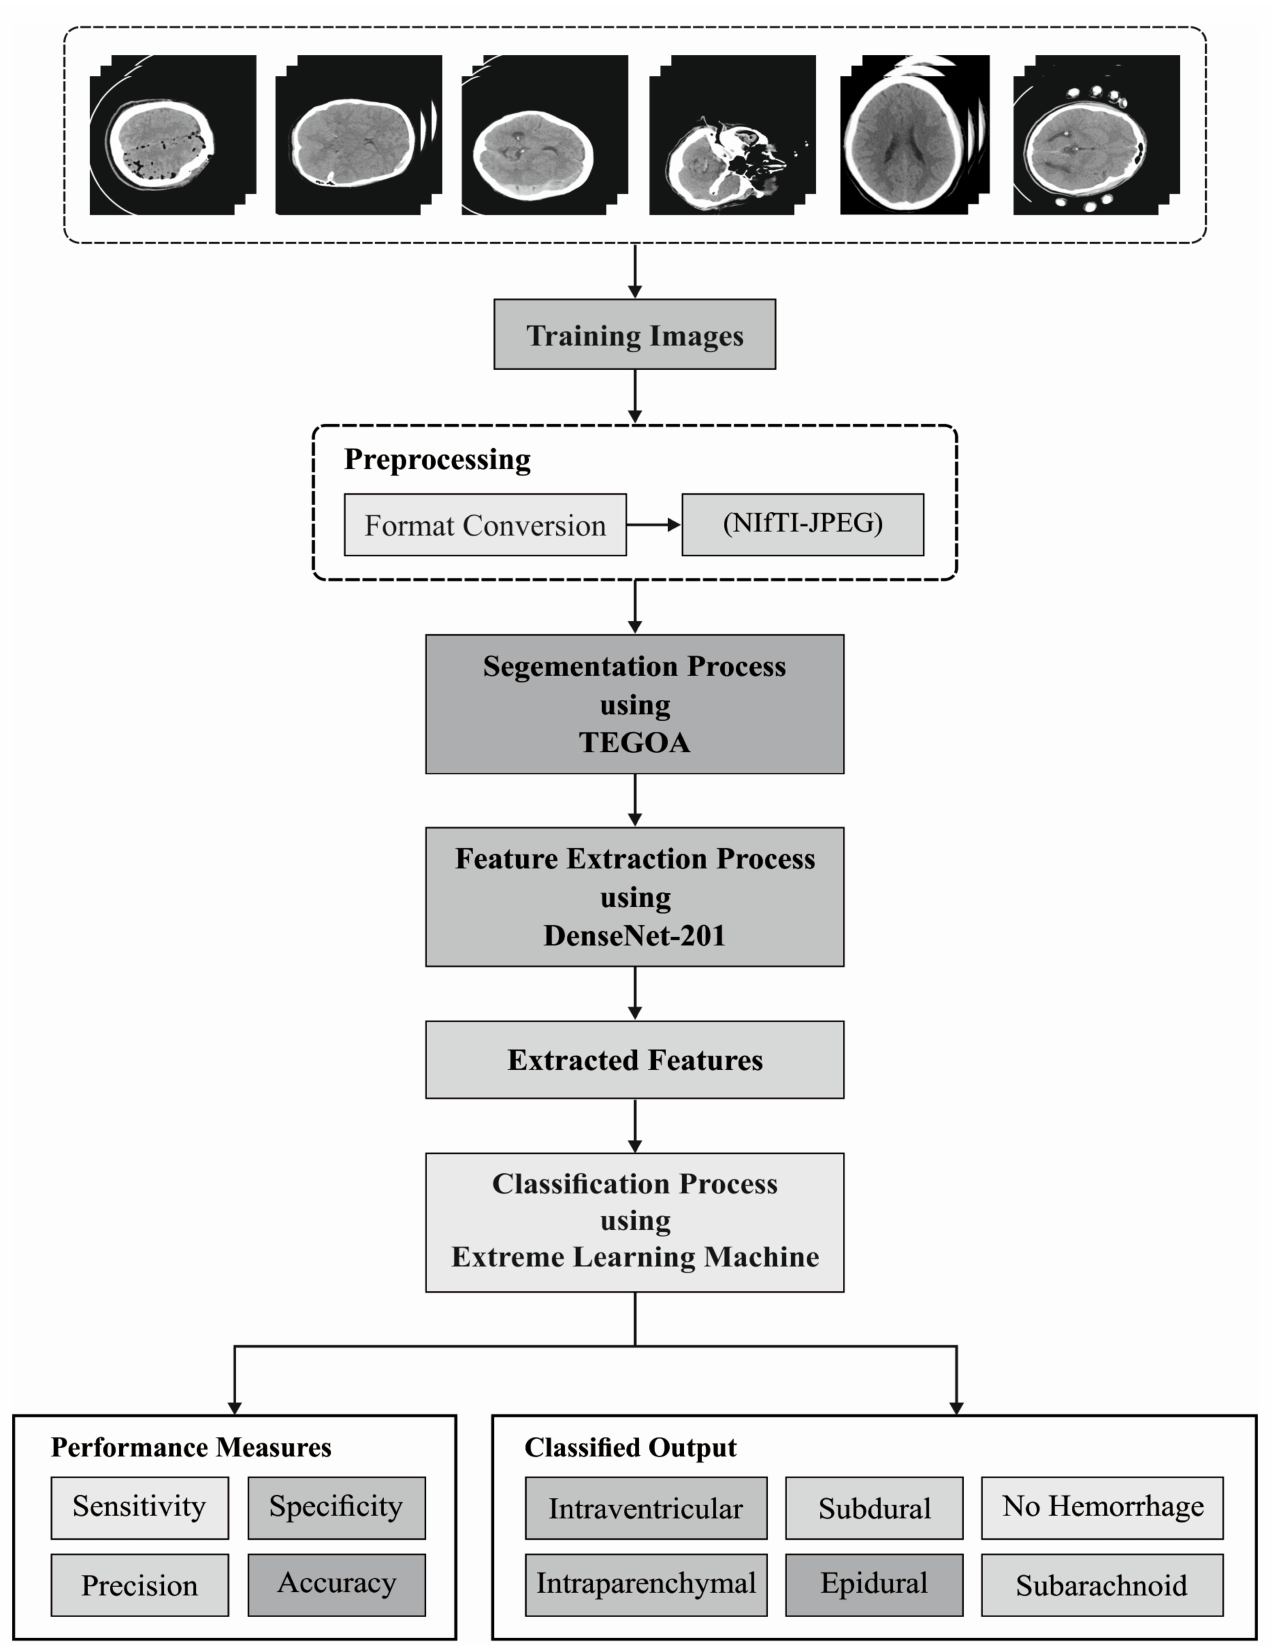
Figure 1. Overall process of the DL-ELM (advancement of deep learning model based extreme learning